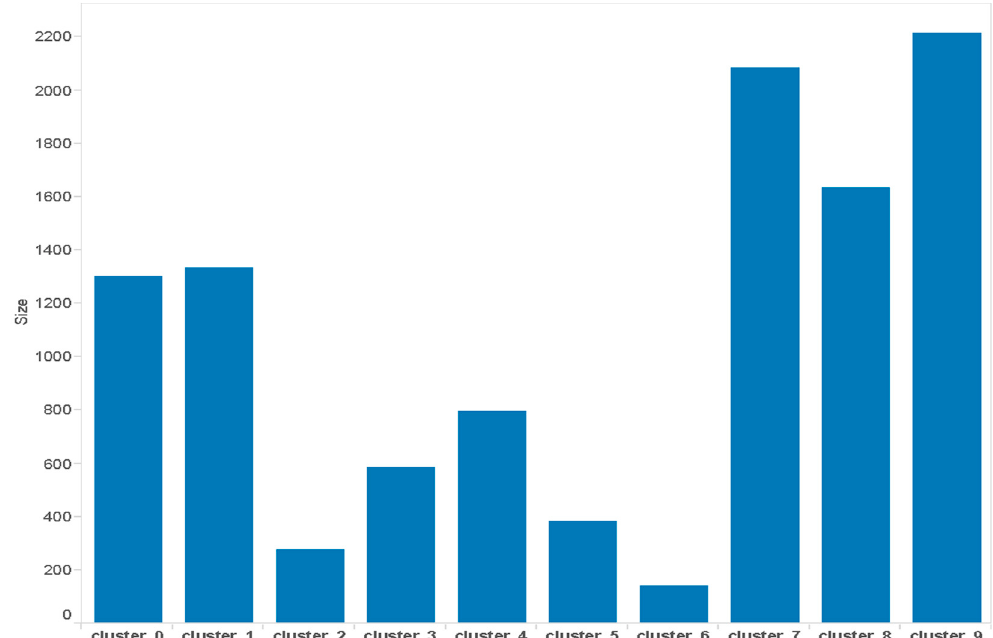
Figure 5. Bar chart for clusters according to size.